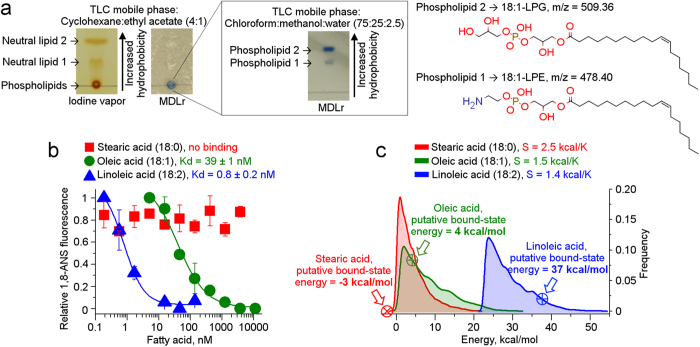
Characterization of the lipids bound to PASb-3α.(a) Two neutral lipids (yellow bands on the iodine vapor stained plate) and two phosphorous-containing lipids (blue bands over white background) were carried over by the purified protein samples. The two phospholipids were identified as 18:1-lysophospholipds. (b) Free oleic and linoleic acids bind with low-nanomolar affinity to delipidated PASb-3α, suggesting that unsaturation is a mandatory feature for the partner fatty acid and, as unsaturation accumulates, the higher the affinity for the protein. (c) Boltzmann distributions representing the canonical ensembles of fatty acid desolvation. The estimated entropies decrease as the degree of unsaturation increase. Crossed-circles over the curves point out the frequency of putative bound-state enthalpy into the distribution.